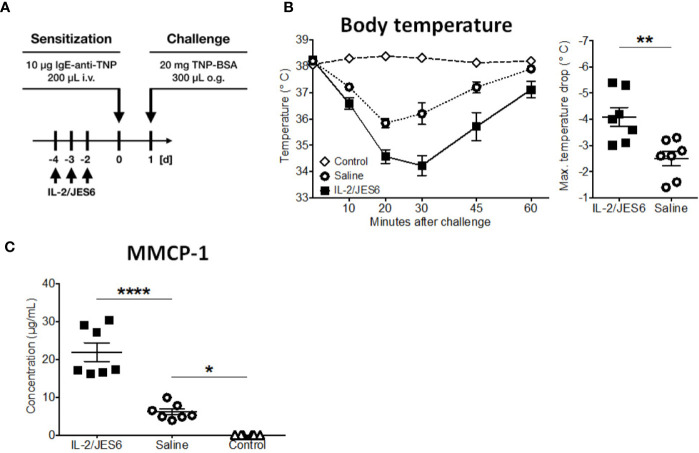
IL-2/JES6 treatment enhances mast cell activation and aggravates IgE-transfer-mediated systemic anaphylaxis. Mice were treated with IL-2/JES6 or saline, passively sensitized to trinitrophenyl (TNP) by transfer of monoclonal anti-TNP IgE and subsequently challenged with TNP-BSA. (A) Treatment regimen. (B) Rectal temperature curve (left) and maximal temperature drop (right) following oral challenge. (C) Serum mMCP-1 as assessed by ELISA. Data represent mean ± SEM (n = 6–7). Data shown from one of two independent experiments. **p < 0.01 (Student’s t-test); *p < 0.05, ****p < 0.0001 (one-way ANOVA followed by Tukey’s post hoc test).